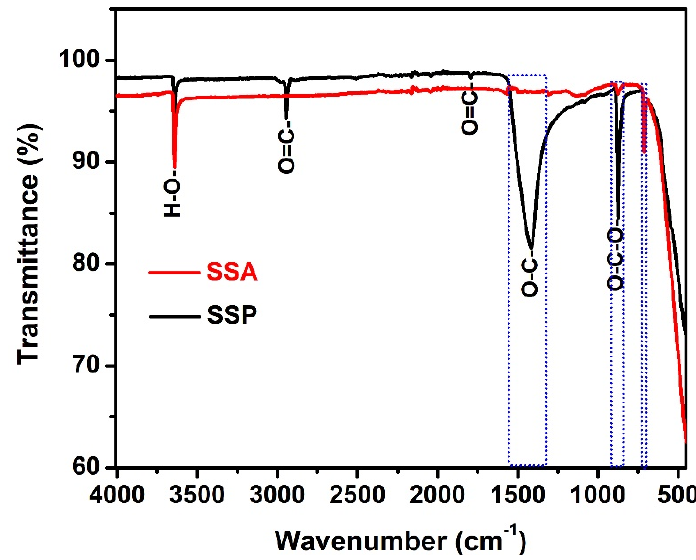
Figure 3 . FTIR spectra of SSP and SSA.